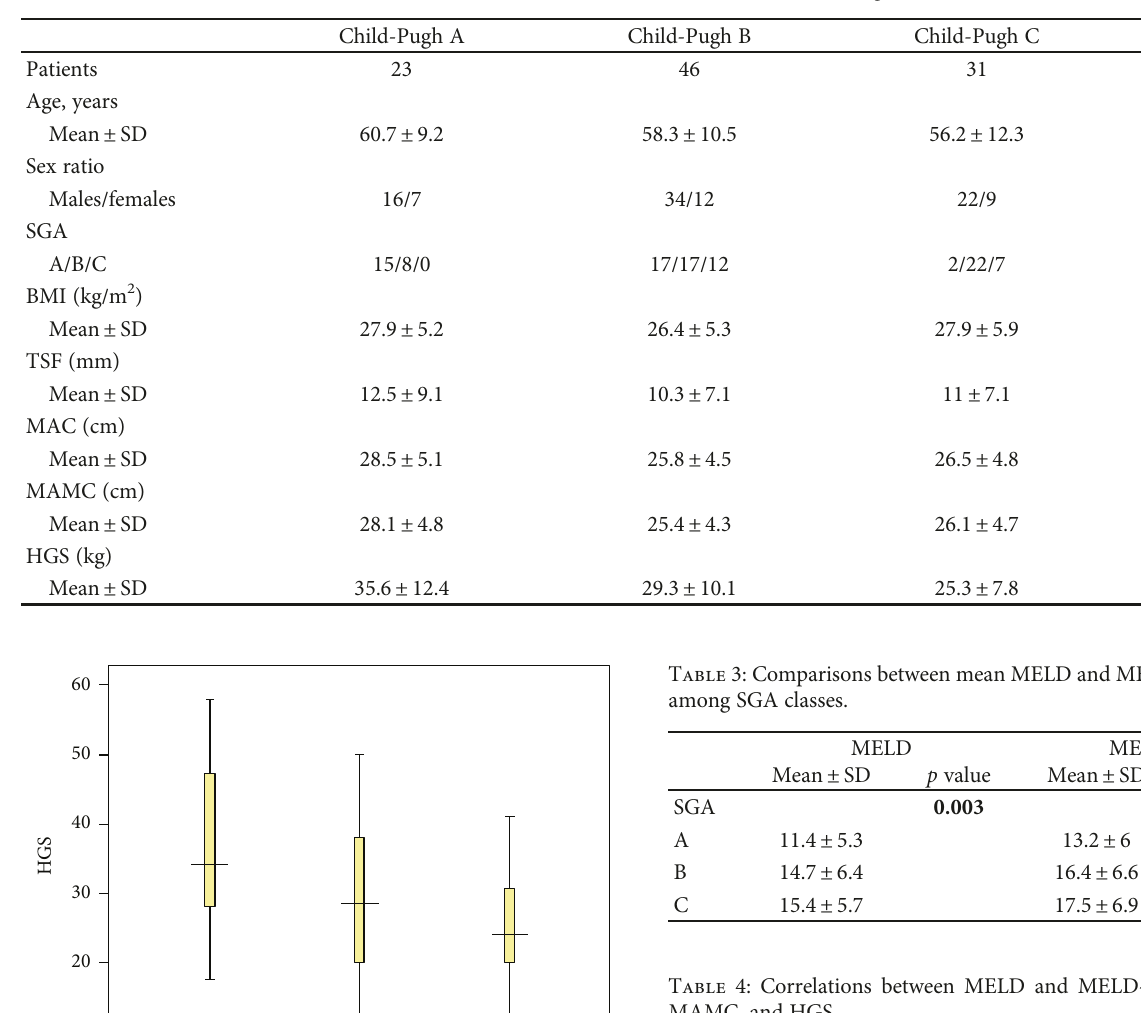
Table 2: Nutritional assessment values in di ff erent Child-Pugh classes.